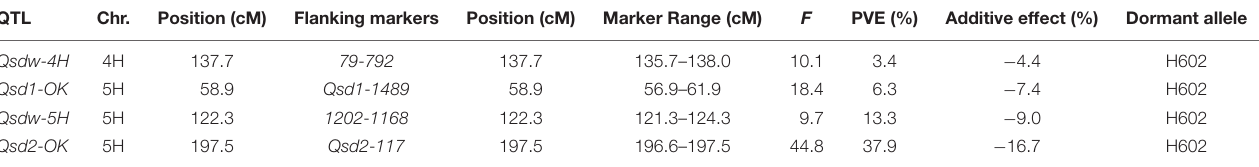
TABLE 2 | Grain dormancy QTL identified by